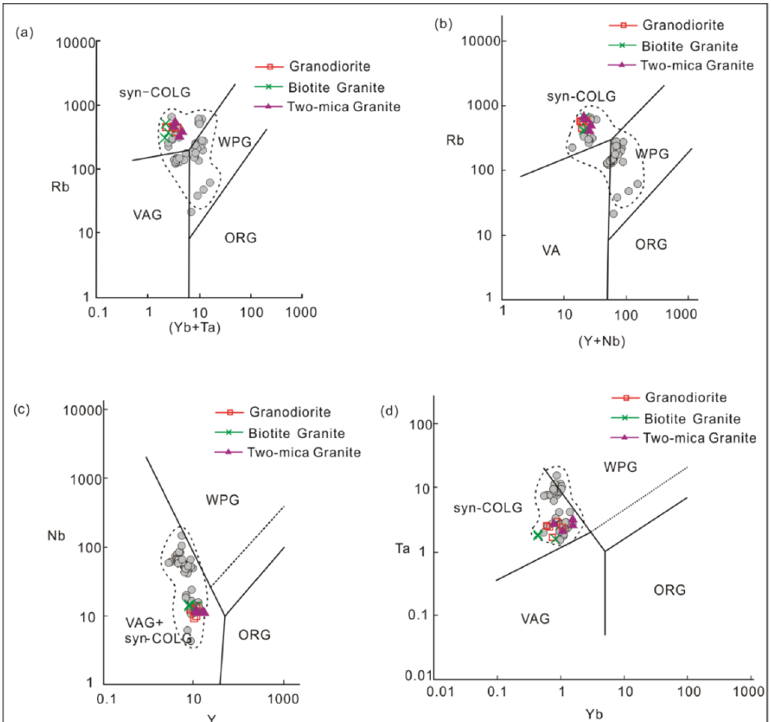
Figure 11. Geochemical classification plots for Zhuxi granites from the Jingdezhen area. ( a ) Rb–(Yb + Ta); ( b ) Rb–(Y + Nb); ( c ) Nb–Y; ( d ) Ta–Yb (all after [108]). Abbreviations are as for Figure 10. The circles in the diagrams denote published data for the Zhuxi granites [38,42,43].